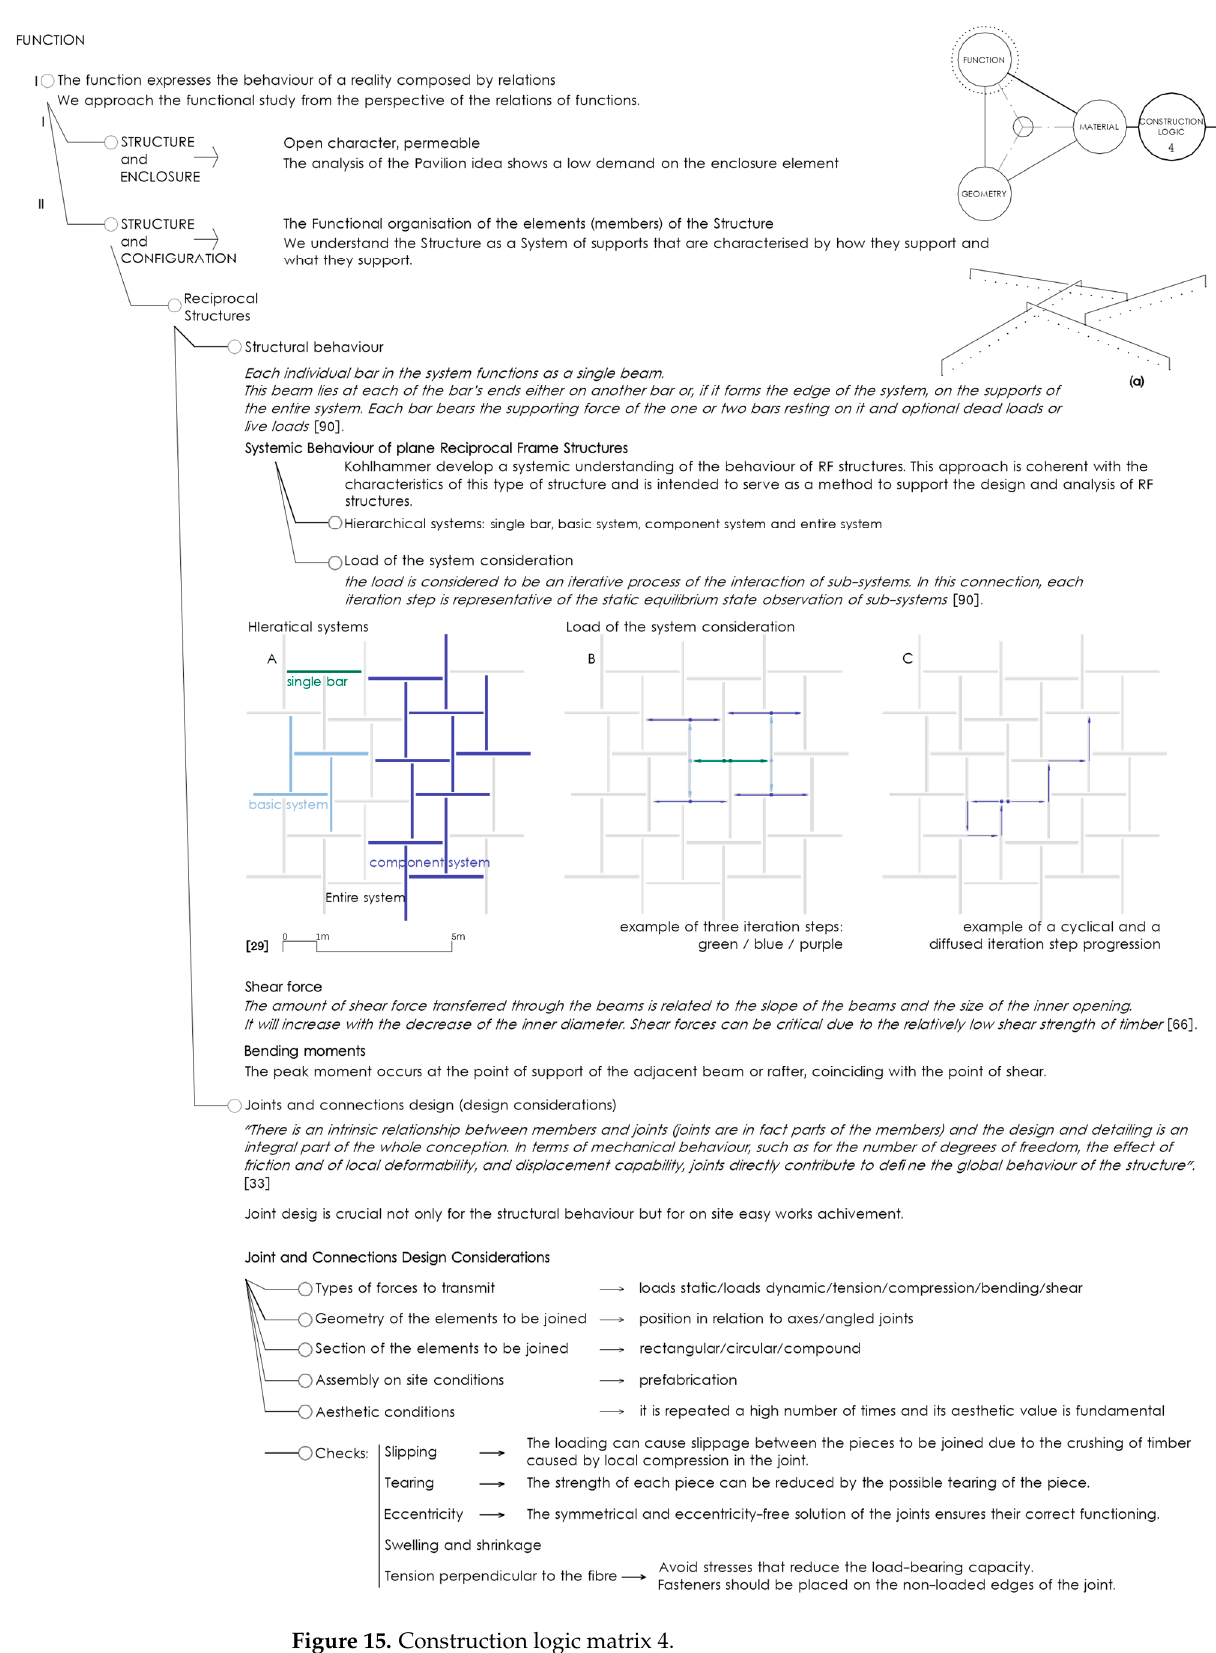
Figure 15. Construction logic matrix 4.